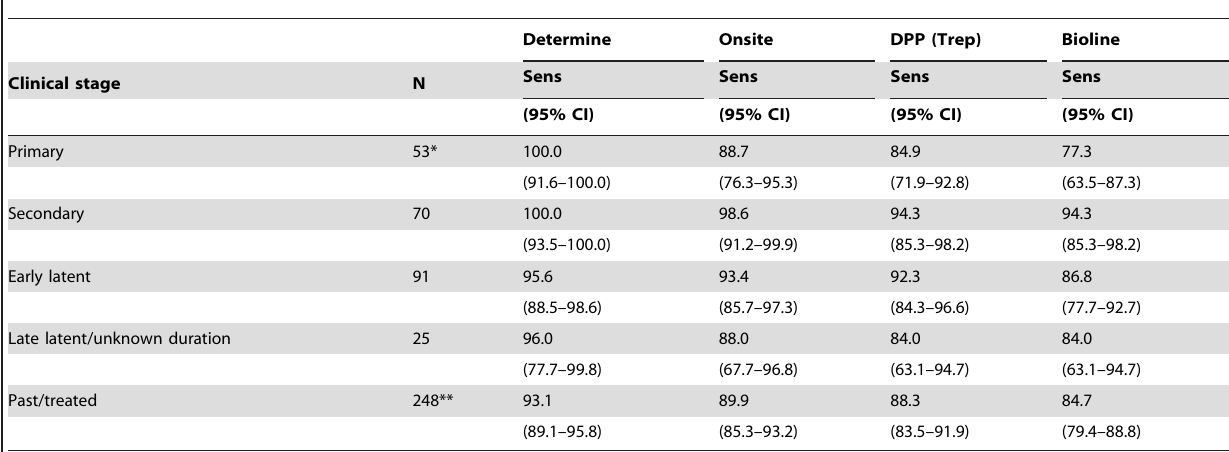
Table 4. Sensitivity of syphilis POC tests compared to clinical syphilis